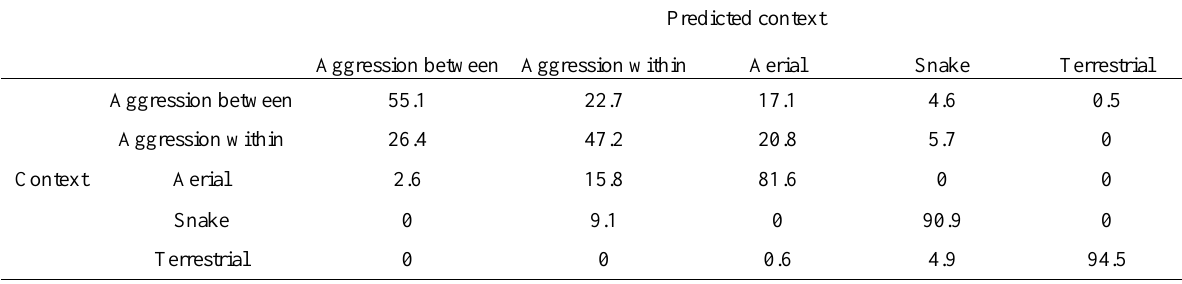
Assignment of Female Vervet Calls Recorded in Alarm and Aggression Contexts to the Respective Contexts, based on the Classification Procedure of a Discriminant Function Analysis of 504 Calls (Modified from Price et al.,